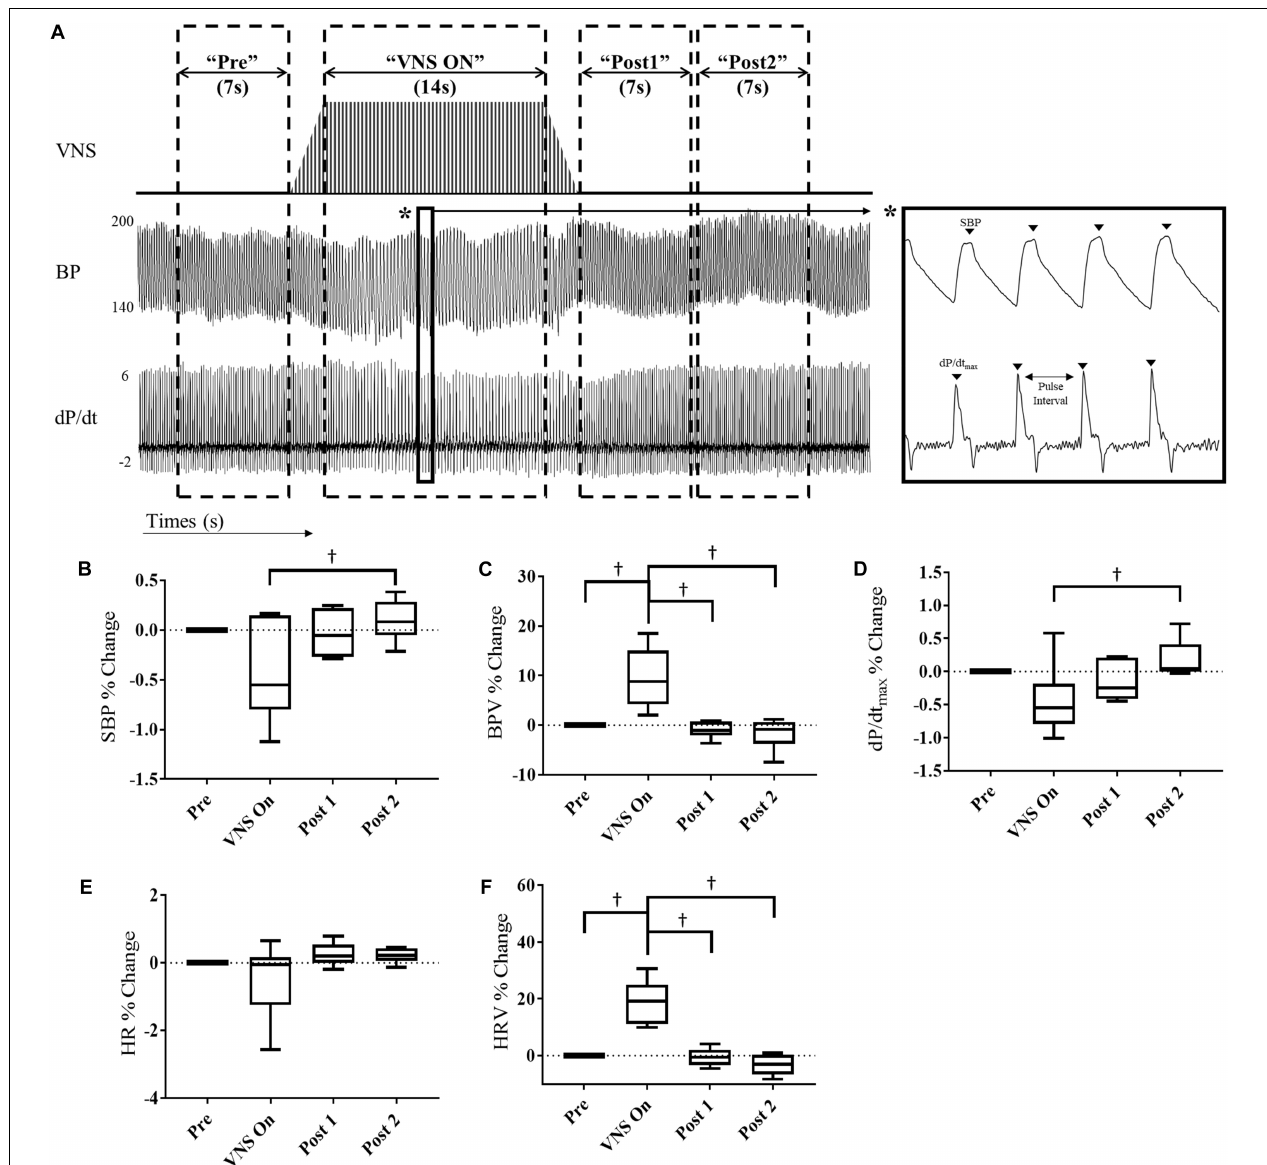
FIGURE 2 | Acute cardiovascular and hemodynamic response of VNS rats ( n = 6) at Week 9. (A) A representative example of VNS stimulation, BP and the BP derivative (dP/dt) traces showing segmentation into “Pre,” “VNS On,” Post 1,” and “Post 2” intervals. Acute SBP (B) , BPV (C) , contractility (dP/dt max ) (D) , HR (E) , and HRV (F) responses during VNS therapy in hypertensive rats for “Pre,” “VNS On,” “Post 1,” and “Post 2” intervals shown as percent change with respect to the “Pre” interval. † Indicates statistical significance between